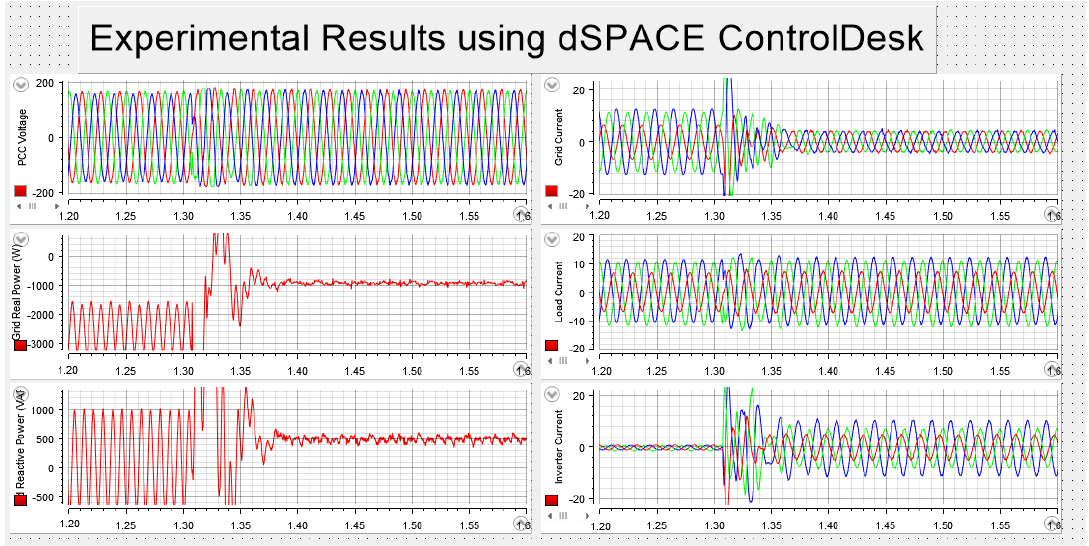
Figure 22. Hardware results using dSPACE Controldesk for real power = − 1 kW and reactive power = 0.5 kvar under balanced grid